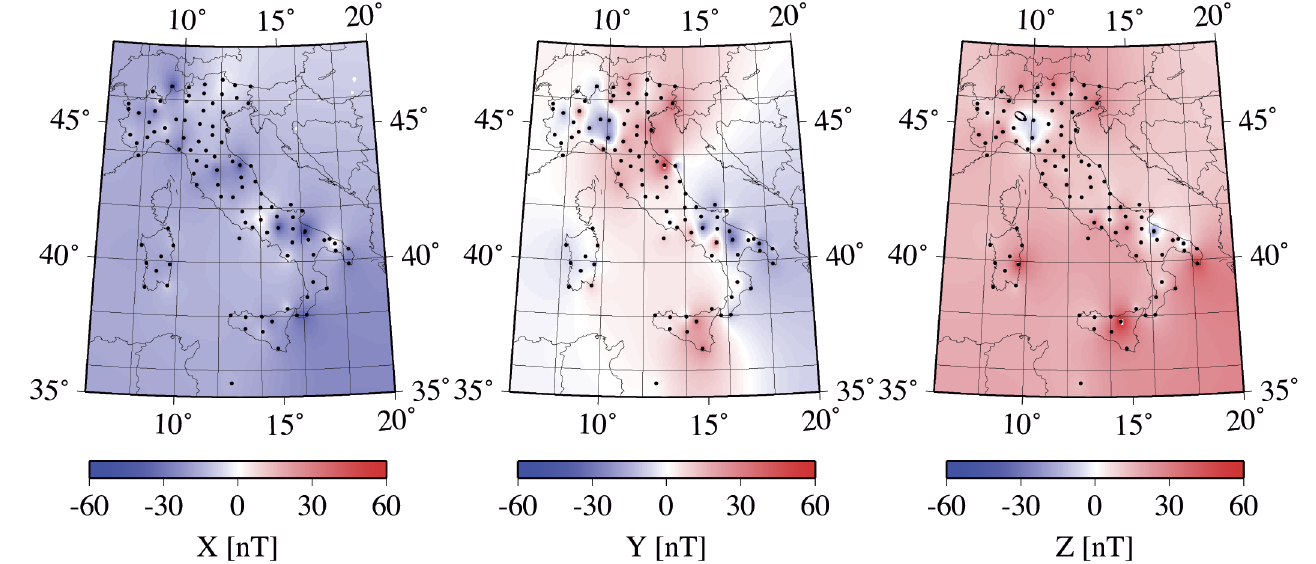
Figure 3. Maps of D R for X , Y and Z components. The average value, estimated over all stations, of D R is of about −16 nT, 2 nT and 16 nT for X , Y and Z , respectively. Black dots indicate the position of magnetic repeat stations.